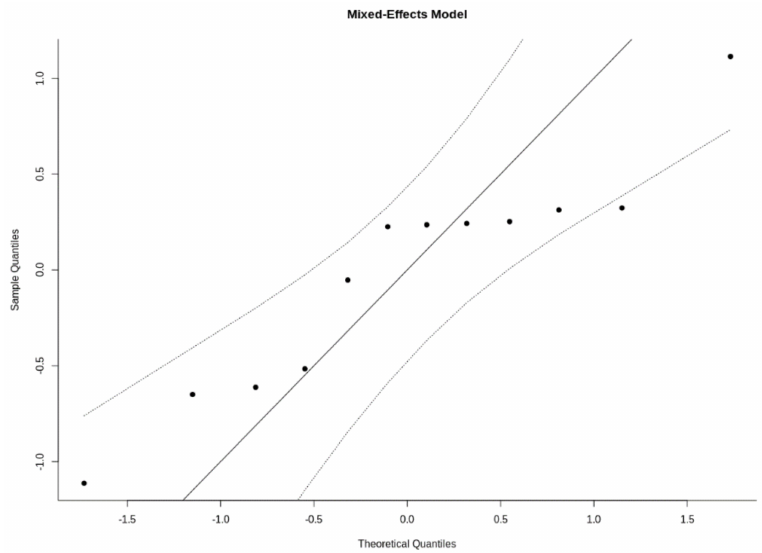
Figure 4. QQ plots for the effect normality assumption (mixed-effects